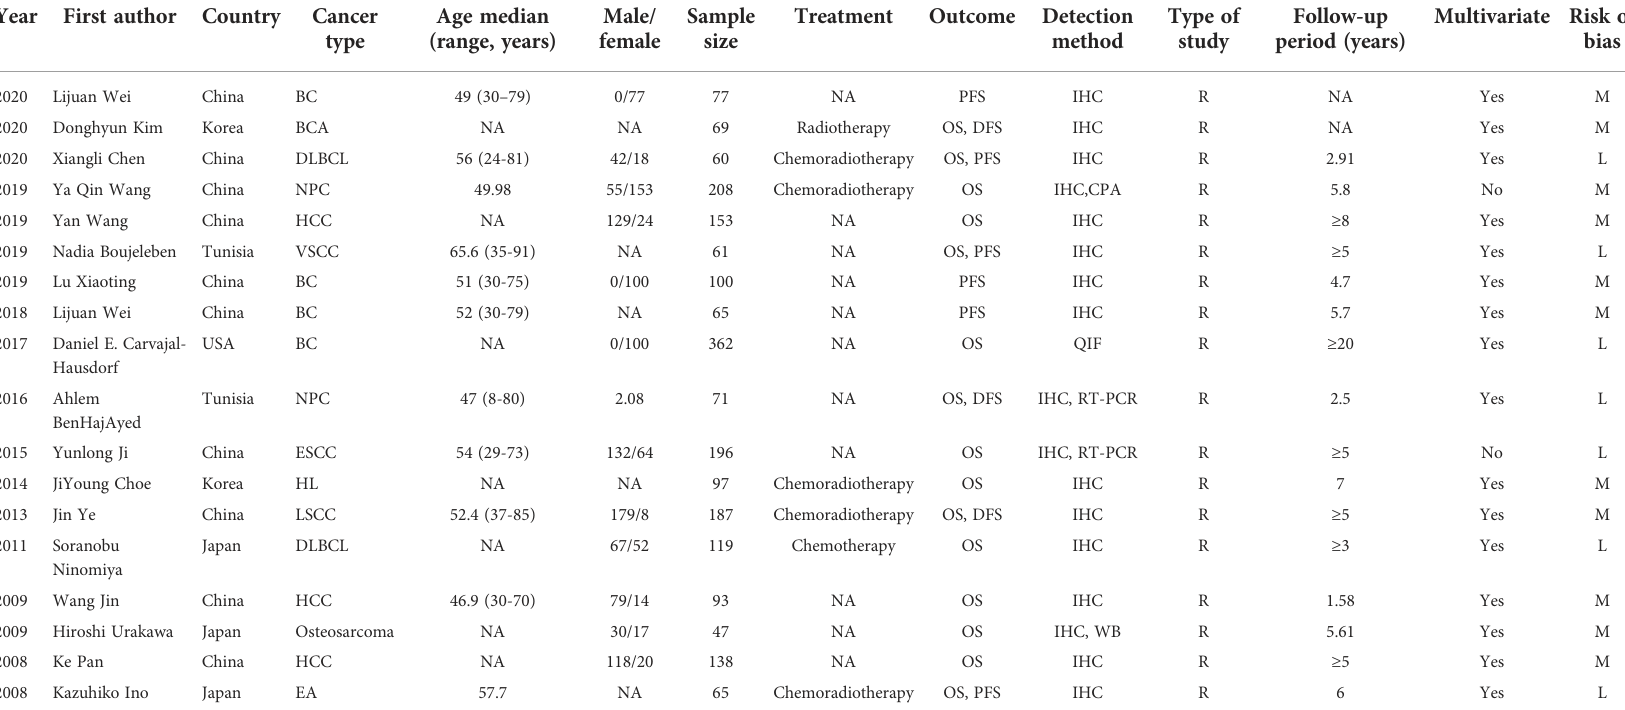
TABLE 1 Characteristics of studies included in the